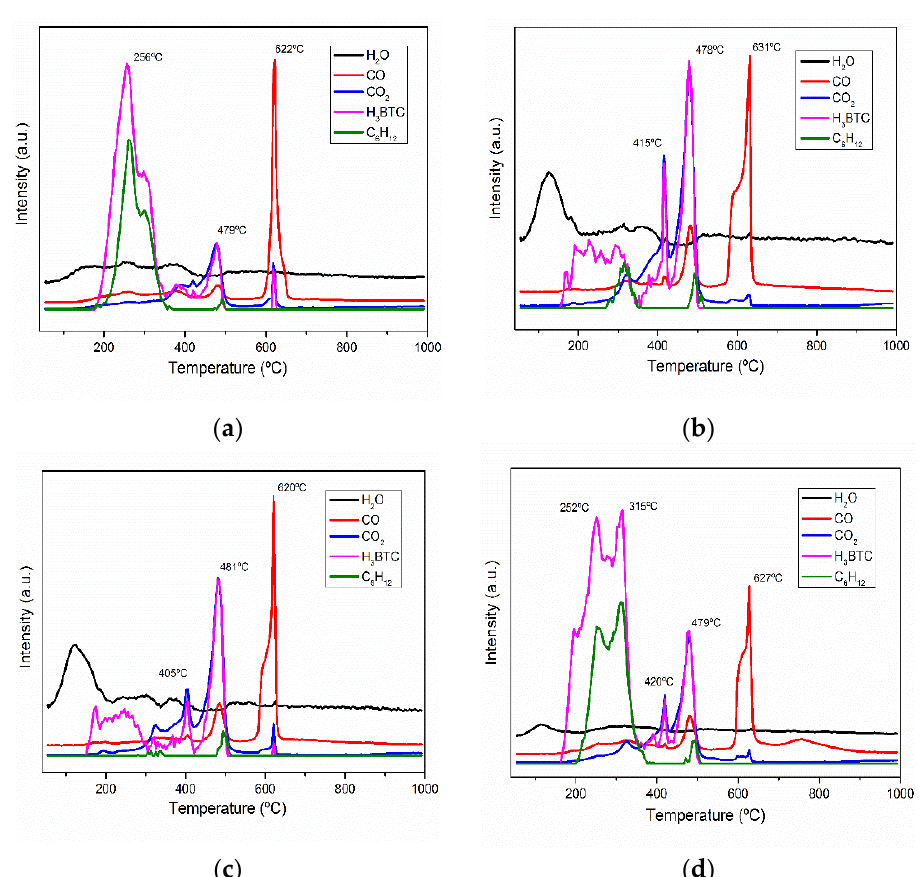
Figure 5. Gases emitted upon thermogravimetry analysis of the samples: ( a ) MIL-100(Fe)-NO F; ( b ) MIL-100(Fe)-HF; ( c ) MIL-100(Fe)-HF:KF; ( d ) MIL-100(Fe)-KF. samples. For MIL-100(Fe)-HF and MIL-100(Fe)-HF:KF, it occurred at temperatures closer to 380 ◦ C, whereas, for MIL-100(Fe)-NO and MIL-100(Fe)-KF, it took place at